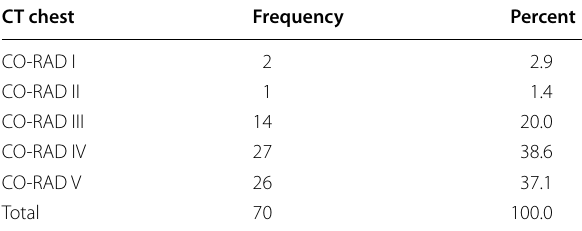
Table 3 The frequency of chest findings in examined